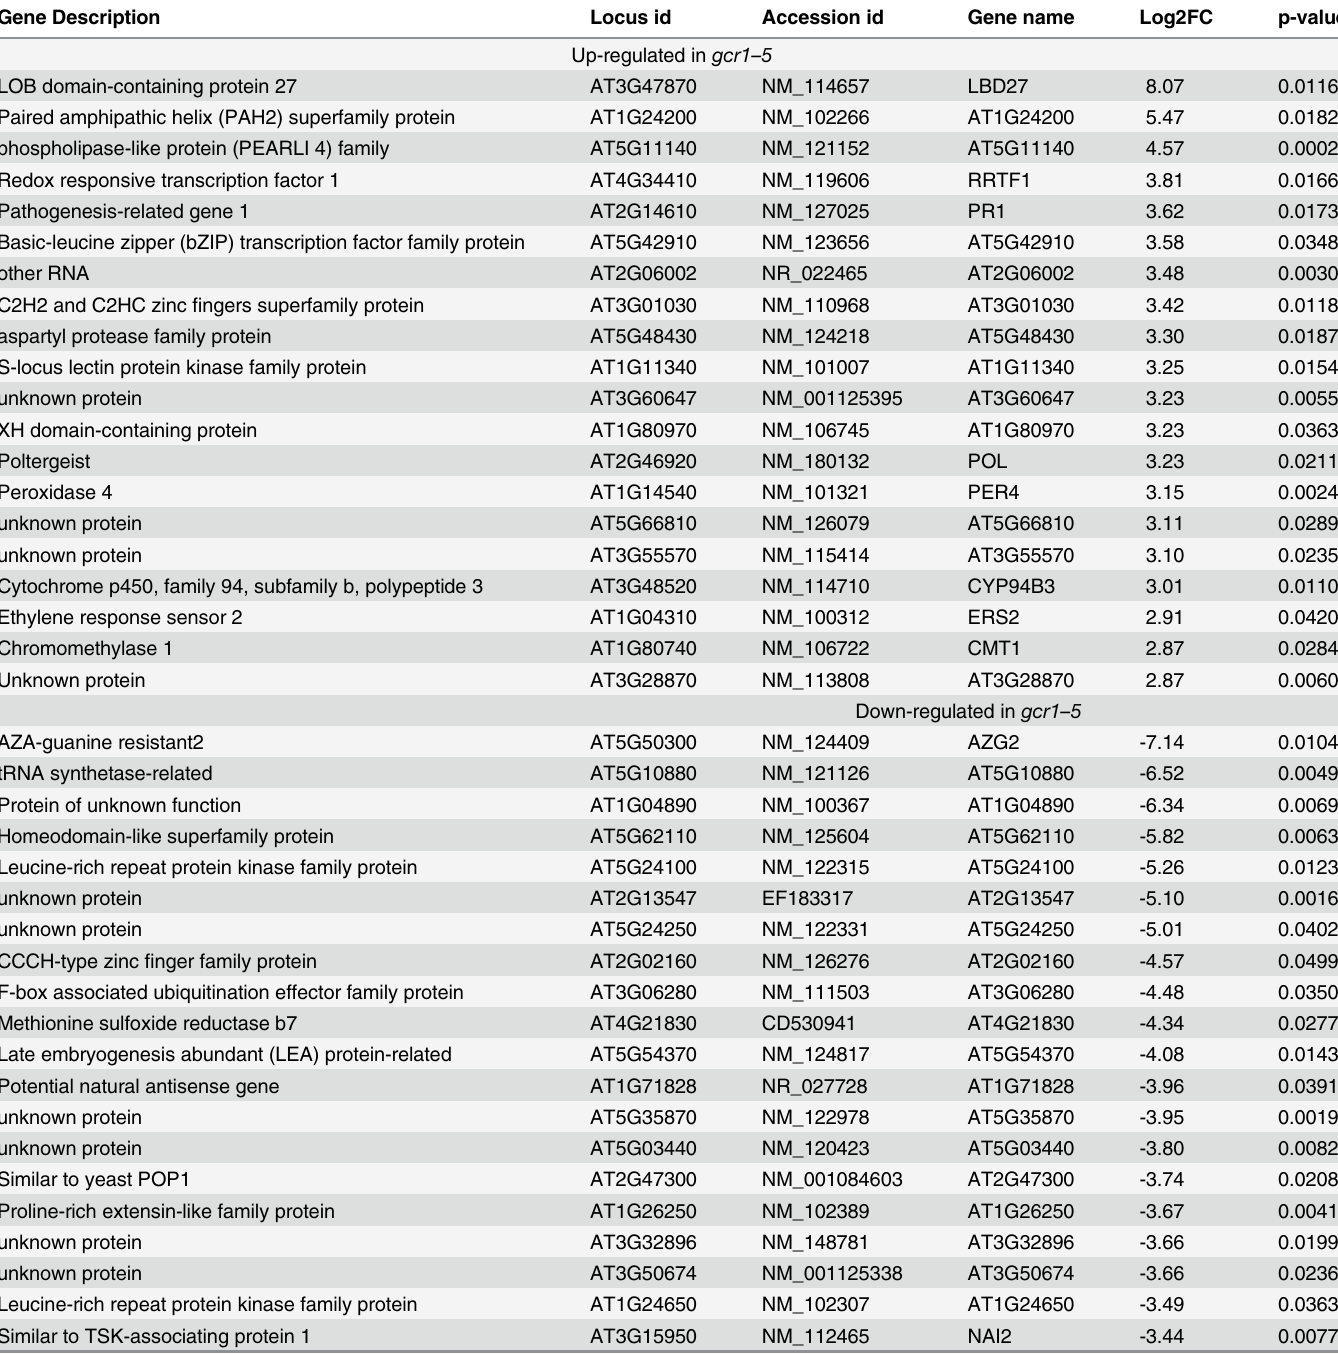
Table 1. List of the top 20 up-regulated and the top 20 down-regulated genes in the GCR1 mutant. Gene